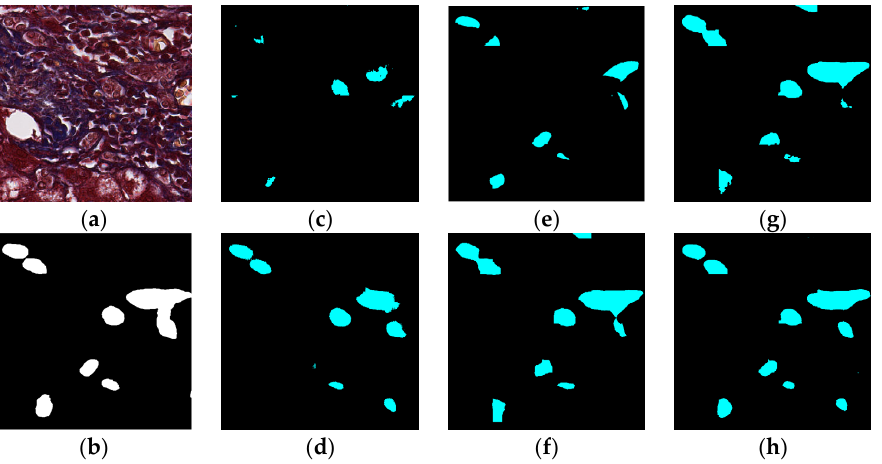
Figure 9. Segmentation results for small ductules stained similar to hepatocyte area: original ( a ), GT ( b ), FCN ( c ), SegNet ( d ), U ‐ Net ( e ), Deeplabv3 ( f ), Deeplabv3 ‐ plus ( g ), and the proposed network ( h ).